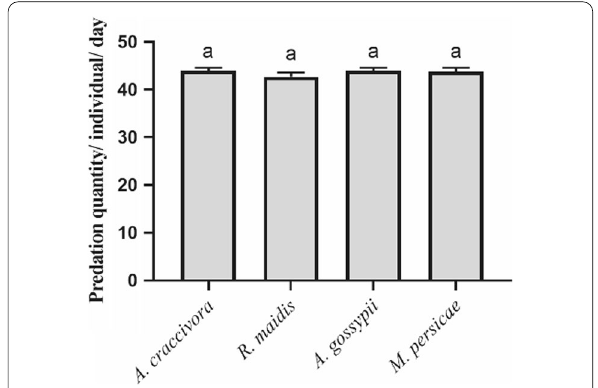
Fig. 1 Non-selective predation of Orius sauteri on the four aphid species. Values are mean SE (Standard Error). The data were ± compared by ANOVA followed by LSD test with α 0.05, and means = indicated by the same letter are not significantly different